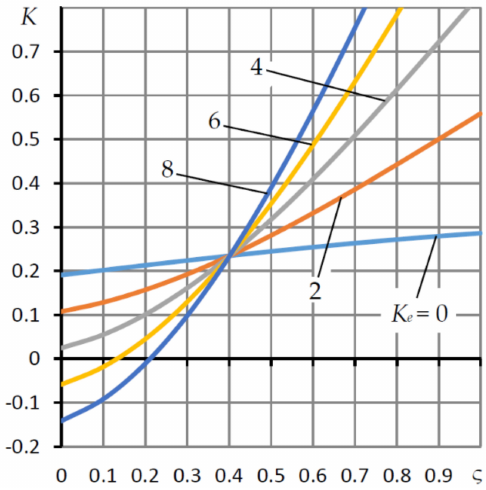
Figure 6. Dependences of static compliance K on the adjustment factor ς for different values of the coefficient of elasticity K e , χ =